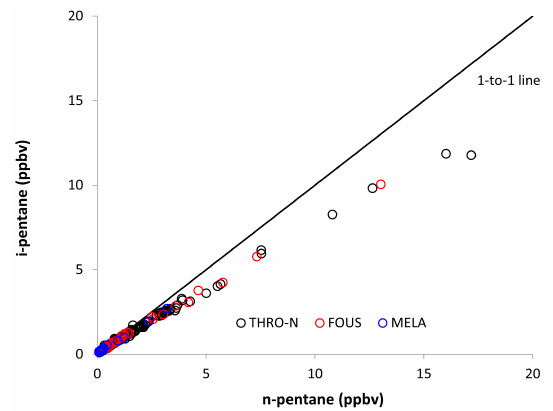
Figure 11. Ratio of iso- to n-pentane for canister samples collected at THRO-N, FOUS, and MELA throughout the second study